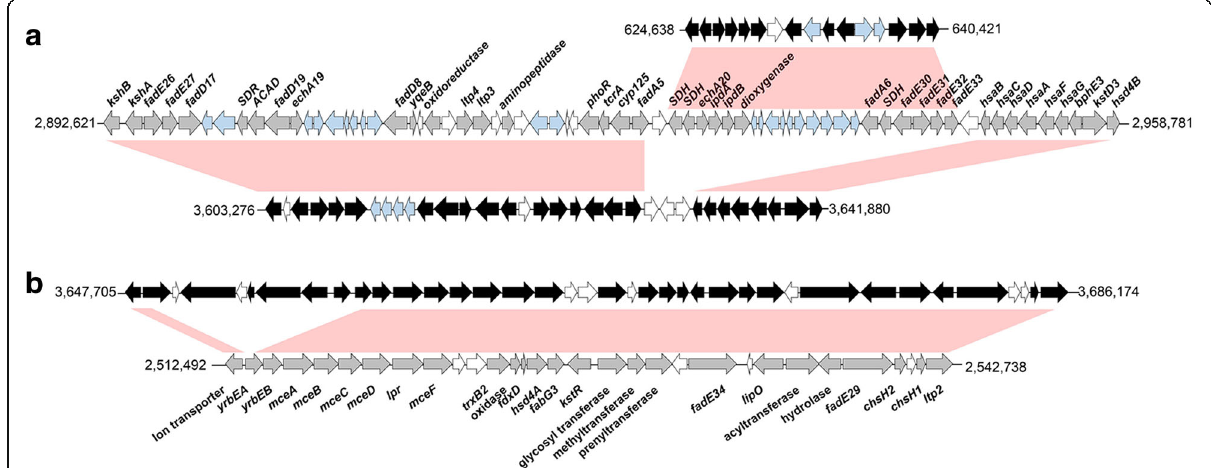
Fig. 4 Steroid degrading gene clusters. Gene clusters were referred from the ones of P. simplex VKM Ac-2033D [35], for which genes associated with steroid degradation are indicated in grey arrows. Genes associated with steroid degradation in N. dokdonensis FR1436 are represented by black arrows . Sky blue indicates genes located in the cluster, but little information associated with steroid degradation. White arrows indicate genes encoding hypothetical protein. a . Gene cluster A involved in degradation of steroid ring A and B [35]. Accession numbers of the genes in P. simplex VKM Ac-2033D are AIY19941 to AIY17666. Accession numbers of the genes in N. dokdonensis FR1436 are ANH39848 to ANH39880 and